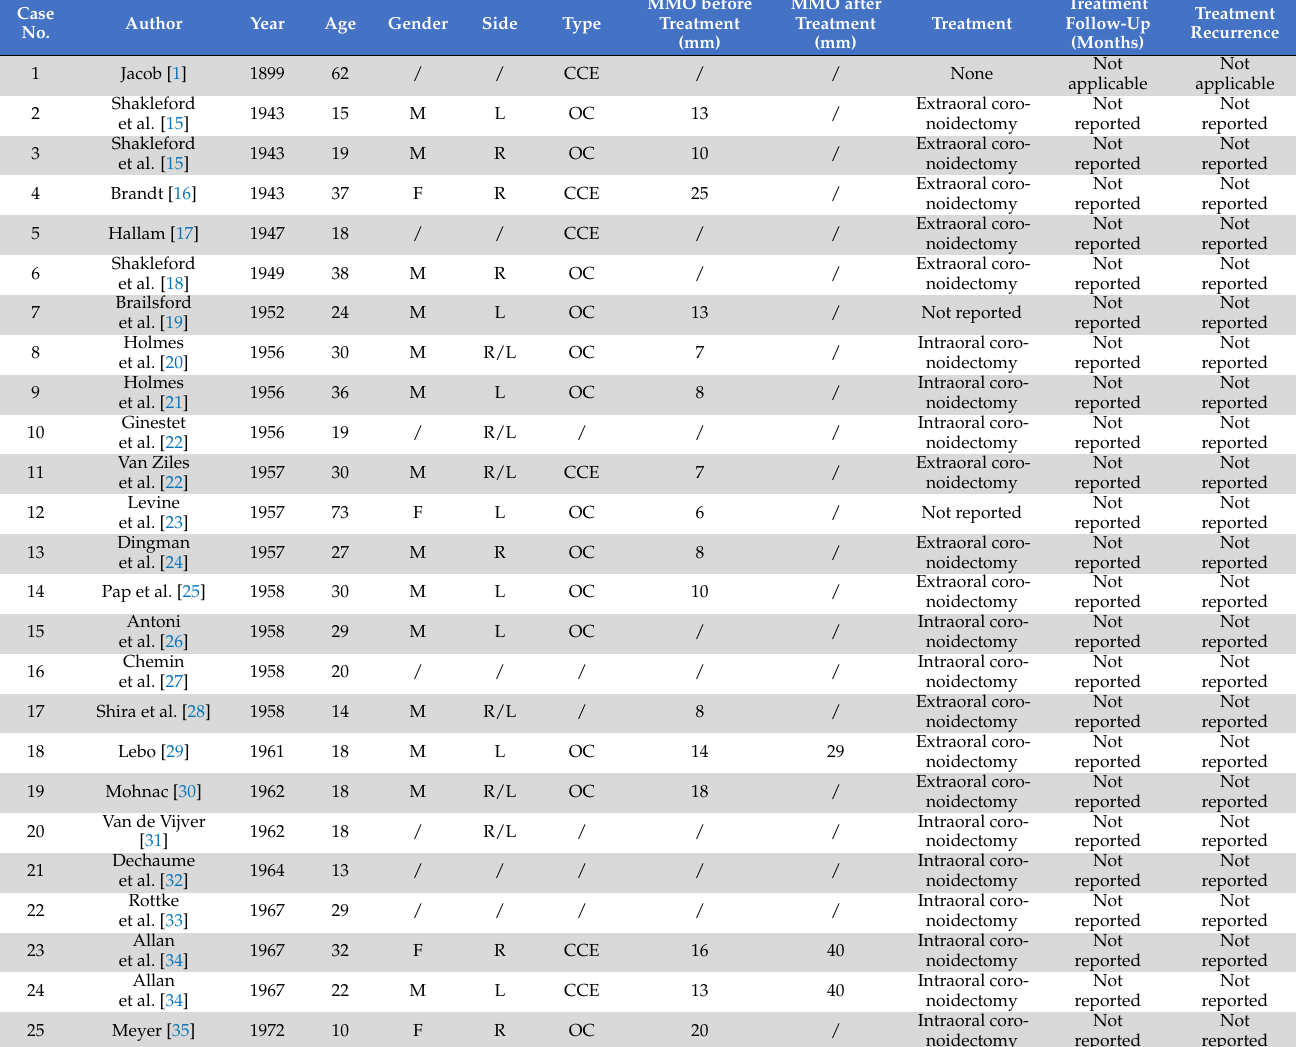
Table 1. Results of the literature review performed, reporting various parameters of interest that will be discussed in the discussion